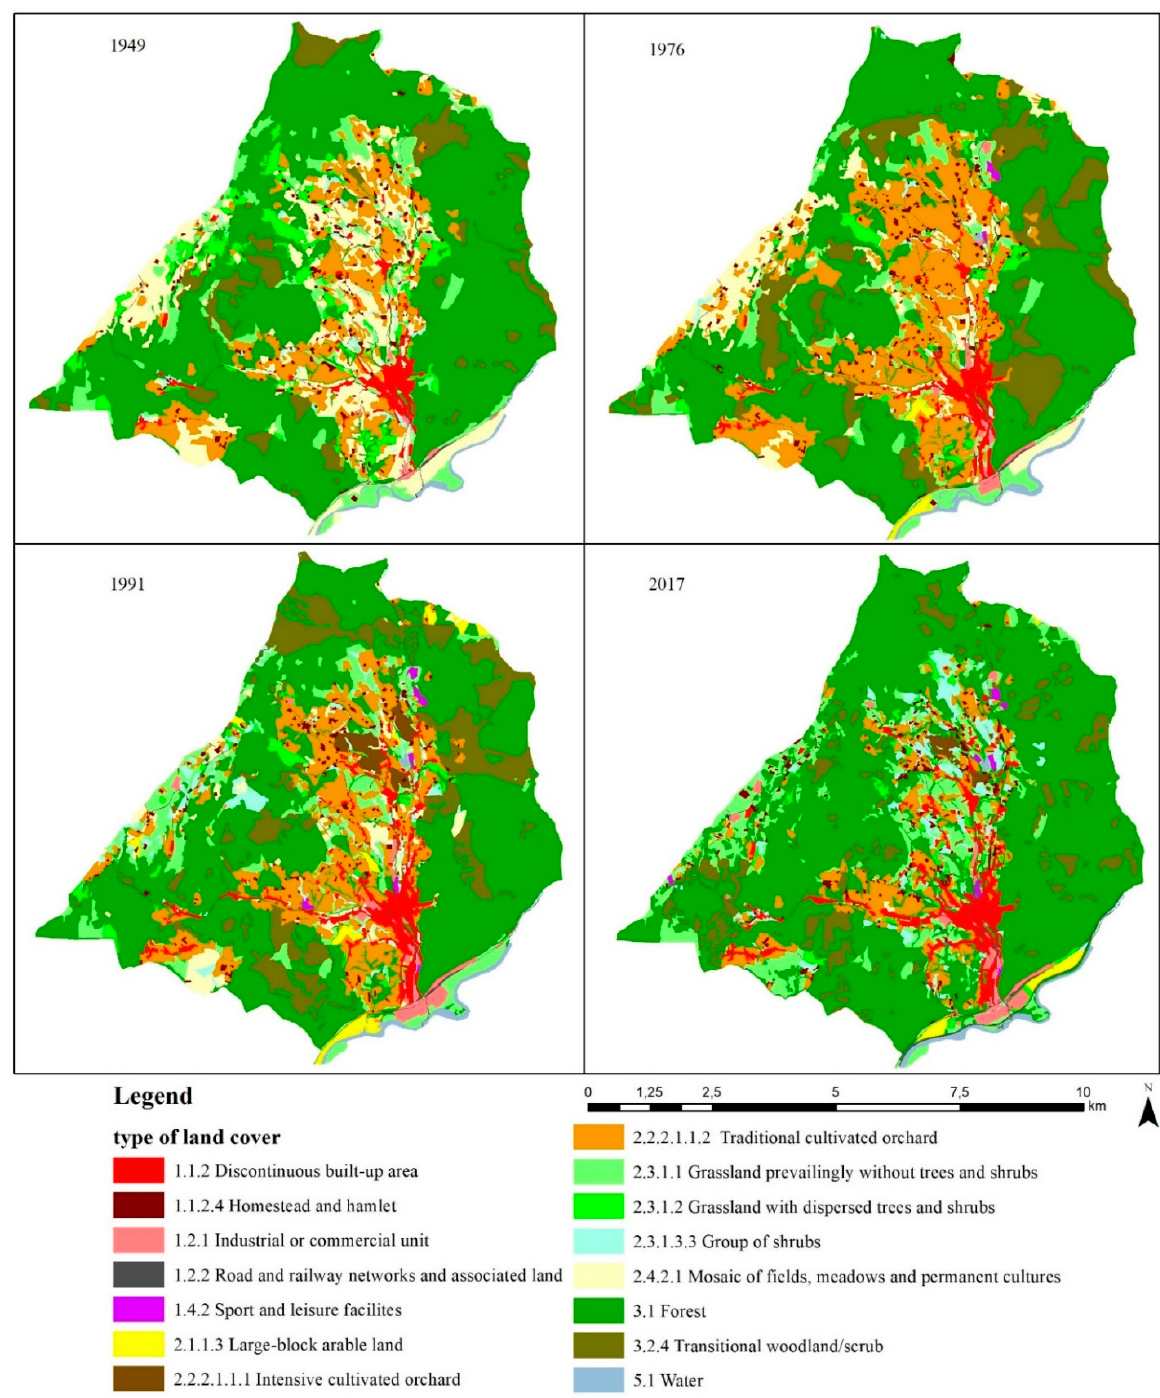
Figure 3. Changes in areas of land cover classes in the cadastral area of Nová Ba ň a over the period 1949–2017. Table 3. Changes in land cover in the cadastral area of Nová Ba ň a over the period 1949–2017. CLC (CORINE Land Cover).